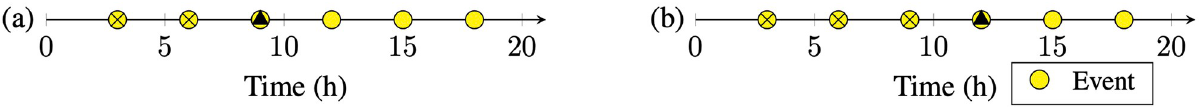
Fig 5. Yellow circles on the timeline axis indicate events. The crossed circles represent the events that are already executed. The filled triangle represents the current simulation time. After a task is executed, the simulation time jumps to the next event in the queue. An exemplary transition is shown by moving from (a) to